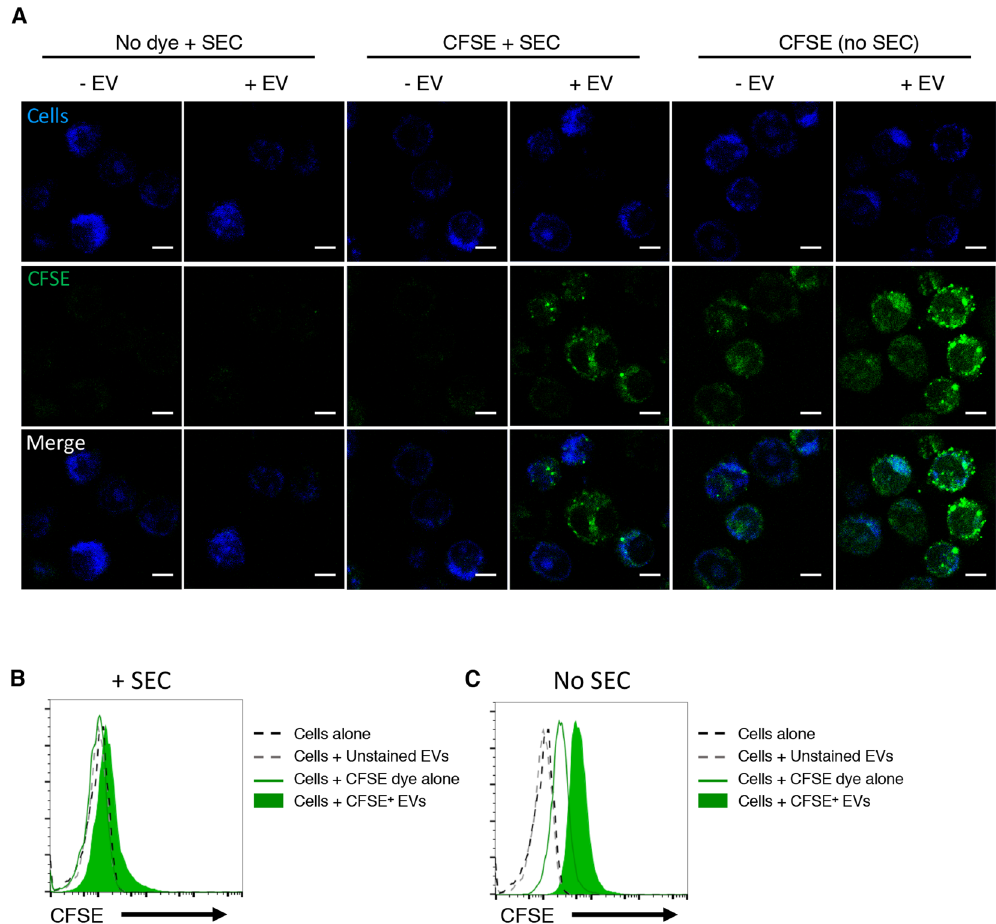
Figure 5. DC2.4 dendritic cells uptake CFSE-labeled EVs. ( A ) Confocal microscopy experiment showing that DC2.4 cells (in blue, stained with Cell Trace Far Red dye) uptake DC2.4 EVs labeled with CFSE (in green) following the staining and size exclusion chromatography method. After size exclusion chromatography, only cells incubated with CFSE labeled EVs are green. In the absence of size exclusion chromatography, cells are fluorescent regardless of the presence of EVs, indicating that unbound dye is the major contributor to the cell staining. Representative images of 5 analyzed fields are shown. All images were scaled in the same way. Scale bar = 5 µ m. The experiment was repeated twice with similar results. ( B ) and ( C ) Fluorescence analysis by flow cytometry of cells shown in A , with ( B ) and without ( C ) size exclusion chromatography after EV labeling. The experiment was repeated three times, with similar results. EV, extracellular vesicle; SEC, size exclusion chromatography.